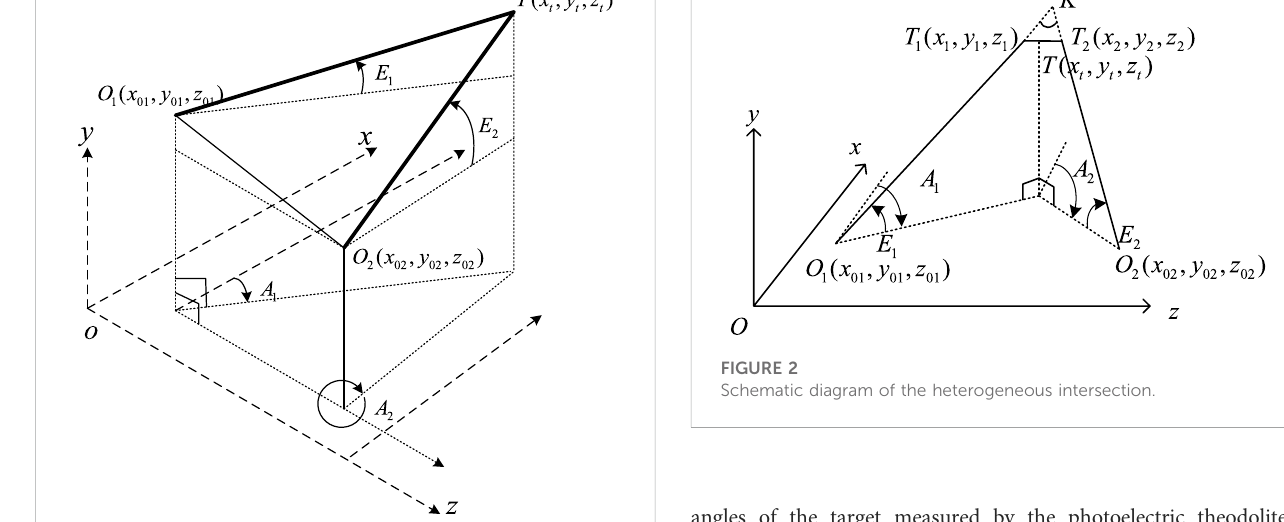
FIGURE 1 Schematic diagram of the coplanar intersection measurement.